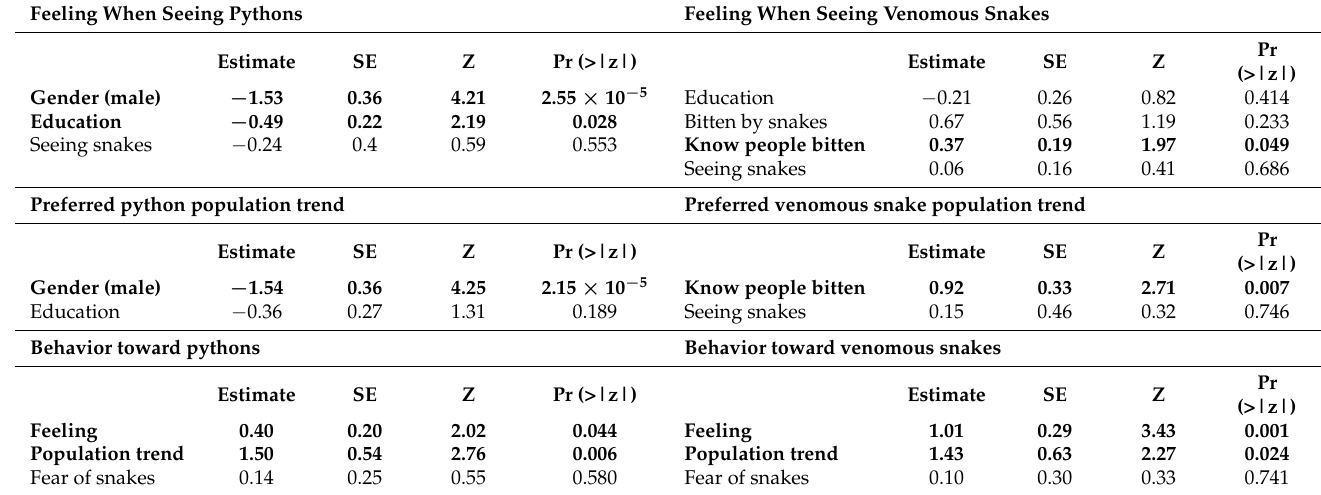
Table 2. Explanatory variables of attitudes and behavior towards snakes based on cumulative link model model-averaging of top models with ∆ AICc < 2. Model-averaged coefficients ( β /Estimate) and standard error (SE) represent the strength of the predictors. Positive coefficients indicating more negative attitudes/behavior (e.g., hate seeing snakes/prefer snake populations to decrease/try to kill snakes). Significant predictors are highlighted in bold.